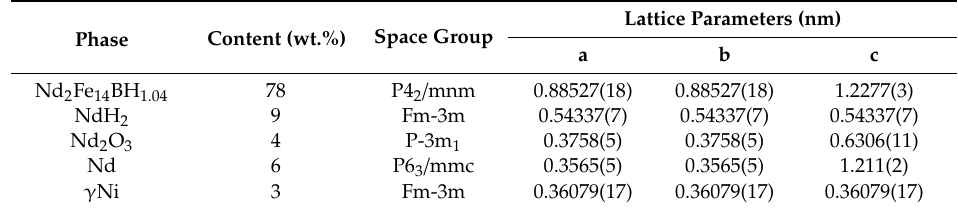
Table 1. Phase composition of the powder mixture obtained after decrepitation of an N42 magnet and its milling with + 2 wt.% NdH 2 .